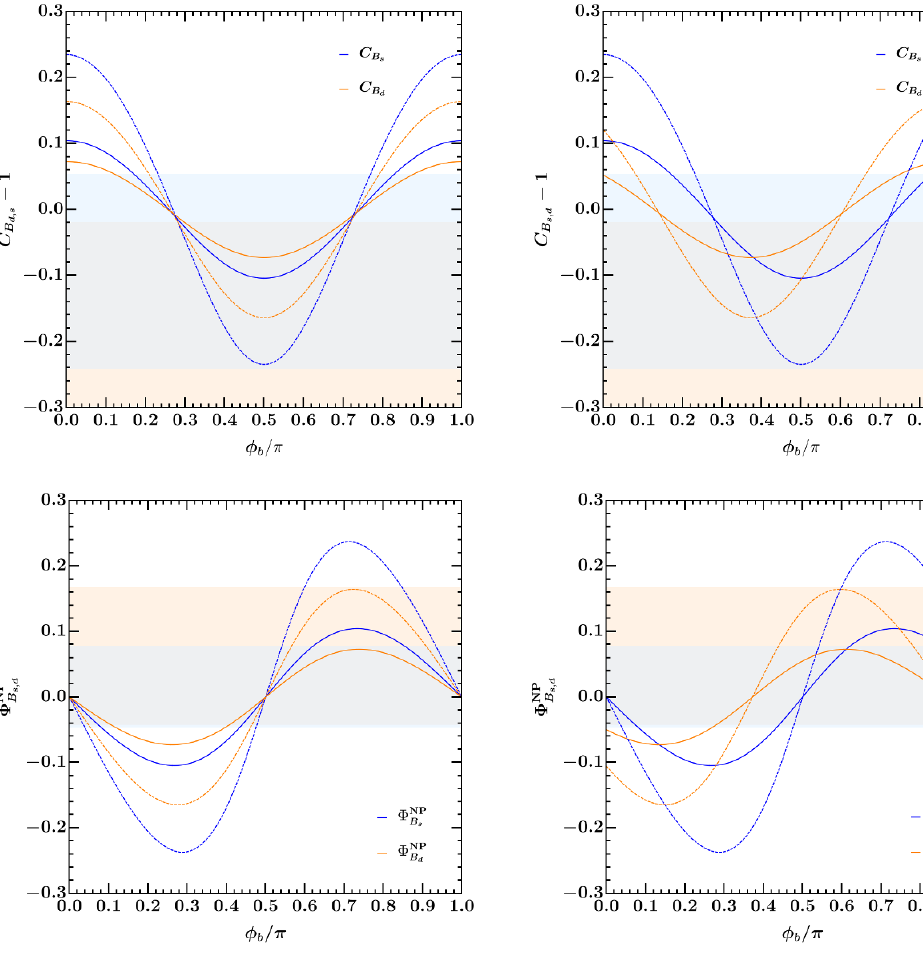
Figure 1 . NP e(cid:11)ects in B s;d (cid:0) (cid:22) B s;d mixing as function of the phase (cid:30) b for (cid:1) (cid:11) d = 0 ; (cid:25) (left) and (cid:11) d = 0 ; (cid:25) (right). The blue and orange bands correspond to the 95% CL experimental bounds for B s and B d mixing, respectively. We use the following inputs: s b = 0 : 10 j V ts j (solid), s b = 0 : 15 j V ts j (dashed), (cid:15) d = 0, g 4 = 3 : 0, M Z 0 = 1 : 75 TeV, and M G 0 = 2 : 5 R